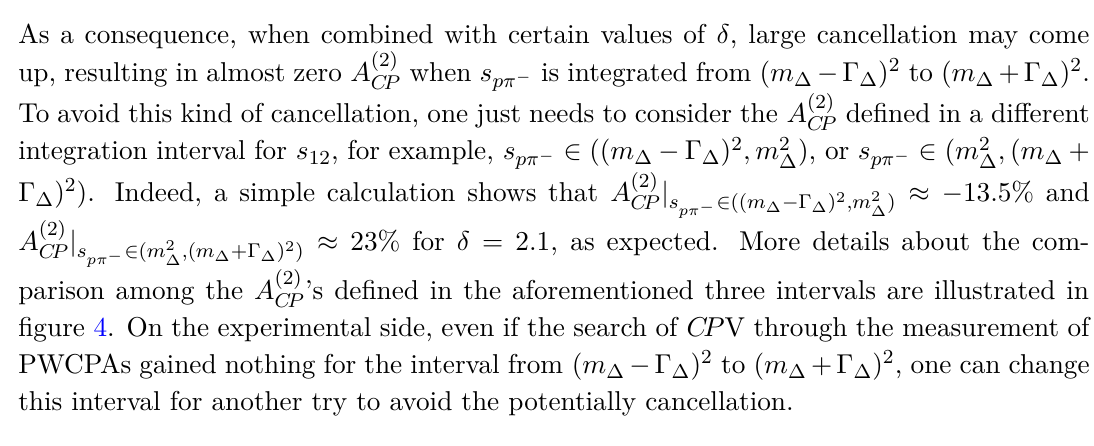
defined in different intervals of s CP , ( m ∆ + Γ ∆ ) 2 ) ∆